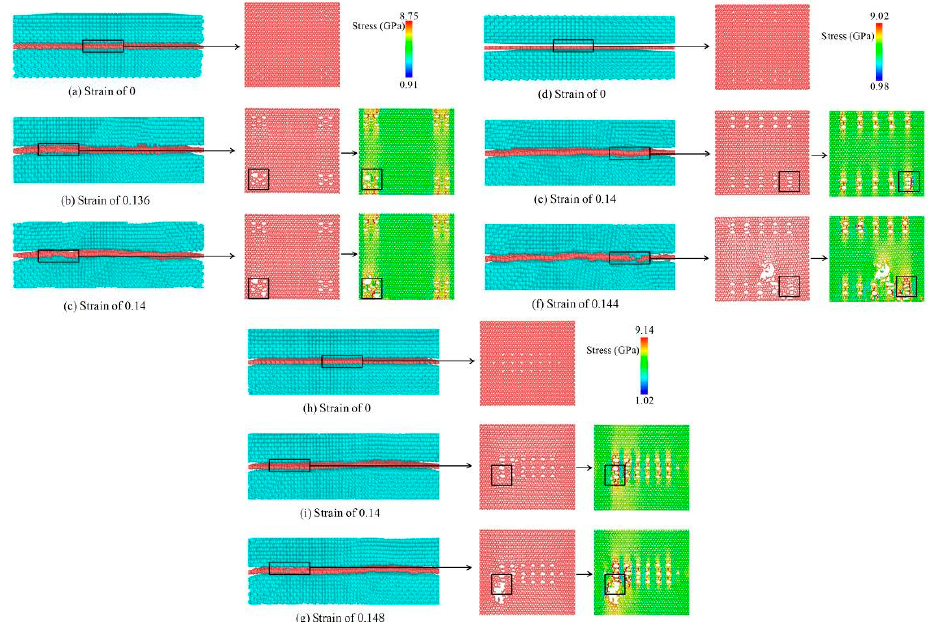
Figure 9. Fracture process and stress distribution of graphene / copper layered composites with ( a – c ) centerline, with ( b – f ) eccentric line, and with ( h – g ) block corner defects at the temperature of 300 K. (Before the load is applied, before reaching the stress limit, and after fracture failure).